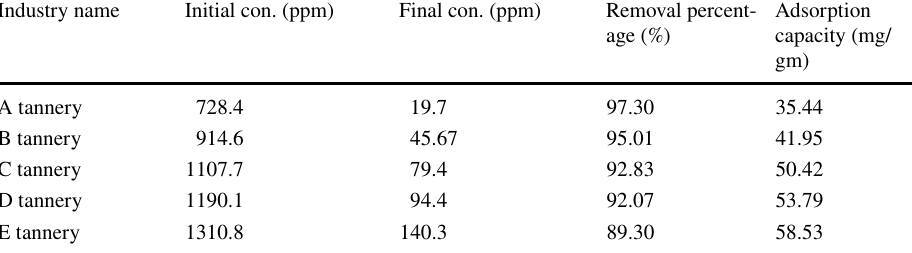
Table 4 Adsorption capacity